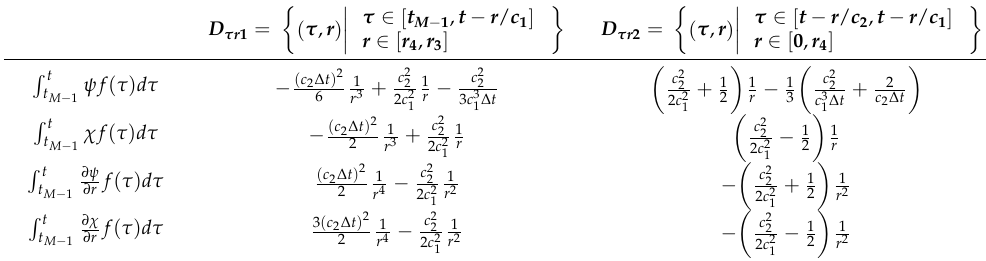
and ∂χ ) in time interval [ t M − 1 , t ∂ r ∂ r